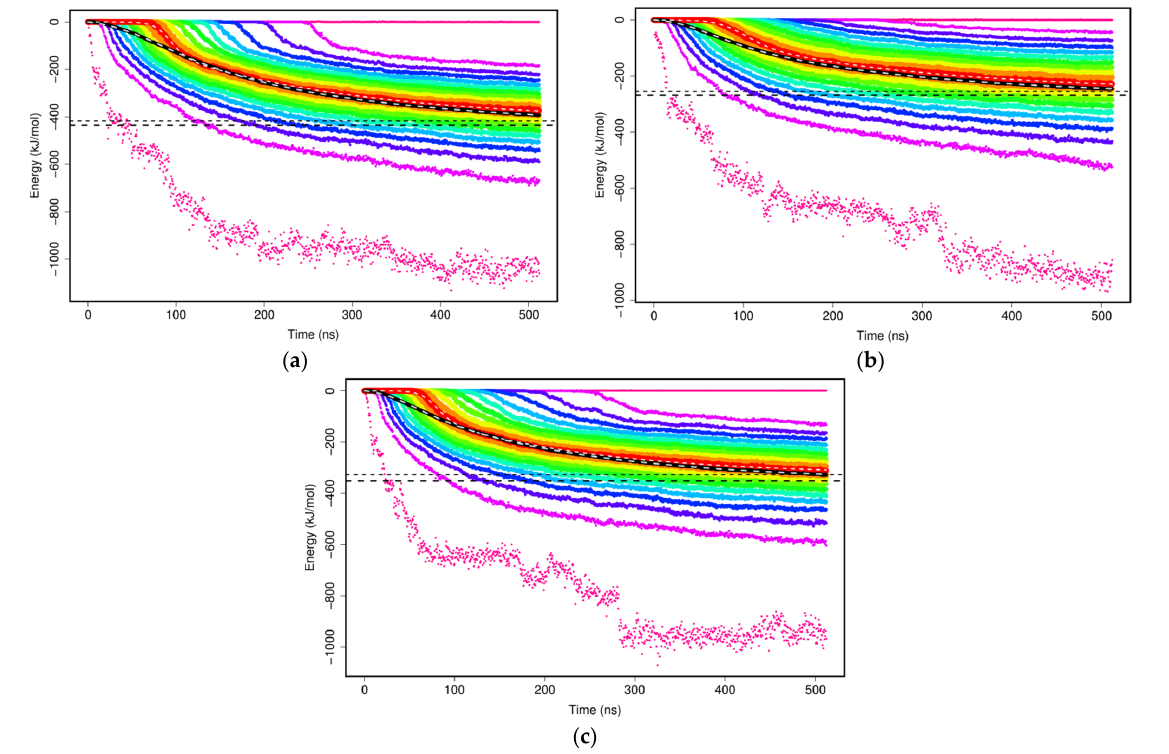
Figure 5. Interaction energy between mAb1 Fv fragment dimers in CGMD simulations. The calculated plateau value of the means for mAb1 Fv fragment dimerisation were determined to be ( a ) − 417.2 kJ/mol in 100 mM NaCl, ( b ) − 253.1 kJ/mol in 100 mM NaCl with 10 molecules of Compound X and ( c ) − 319.18 kJ/mol in 100 mM NaCl with 10 molecules of trehalose. Table 2. The calculated plateau value from the mean interaction energy distributions in different systems. Addition of trehalose cause increase in the mean interaction energies and a higher mean interaction energies achieved in systems with Compound X , suggesting self-interactions of mAb1 Fv fragments are energetically less favourable in systems with trehalose or Compound X . − 319.8